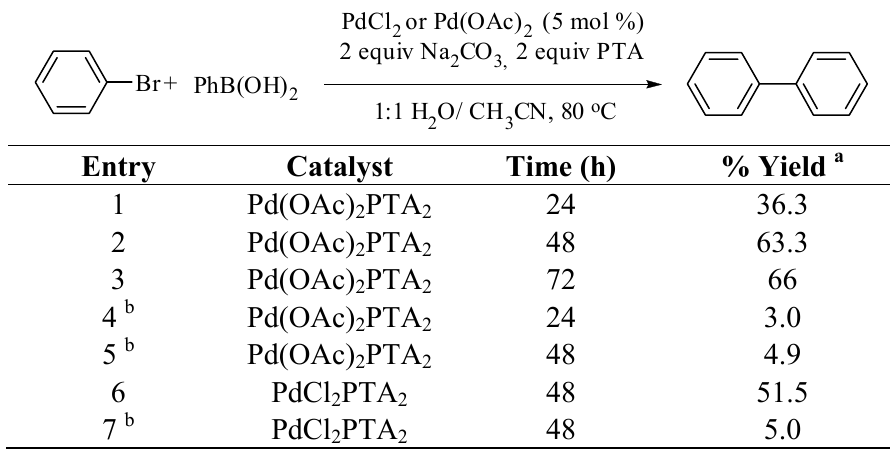
Table 1. Suzuki Coupling catalyzed by Pd(II) and PTA with and without Hg.